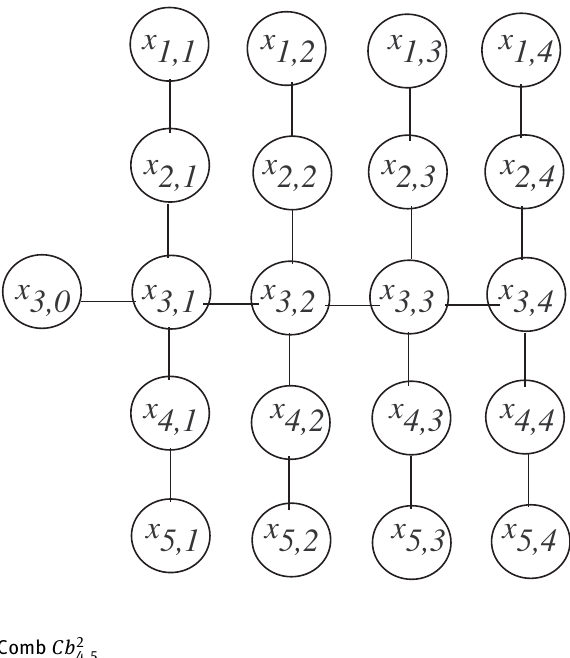
Figure 2: 2-sided Generalized Comb Cb 2